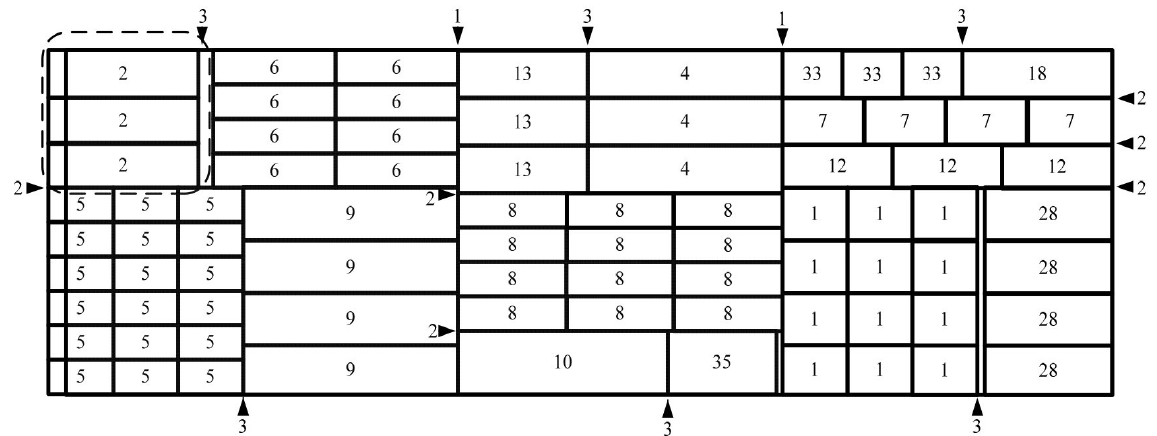
Figure 6. The 3HSX layout and its cutting